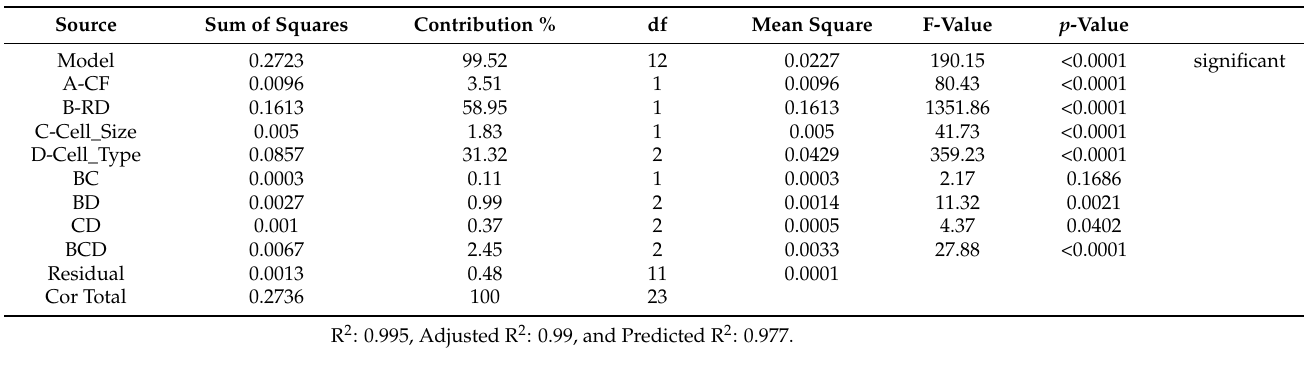
Table 5. Reduced ANOVA table of E.